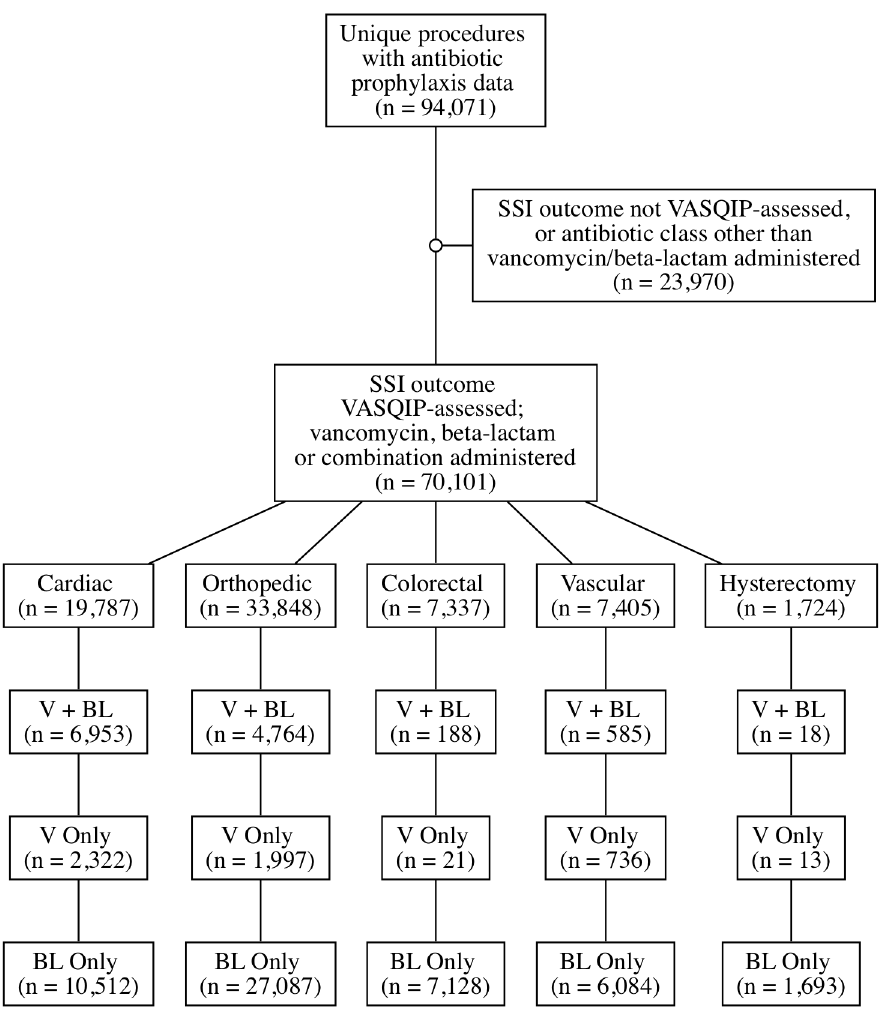
Fig 1. Creation of cohort: Eligible surgeries and distribution by surgical prophylaxis regimen. BL, beta lactam; SSI, surgicalsite infection; V, vancomycin; VASQIP, VeteransAffairs SurgicalQuality Improvement